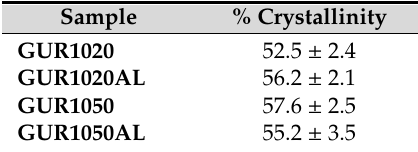
Table 5. Crystallinity percents measured by DSC; N = 4.